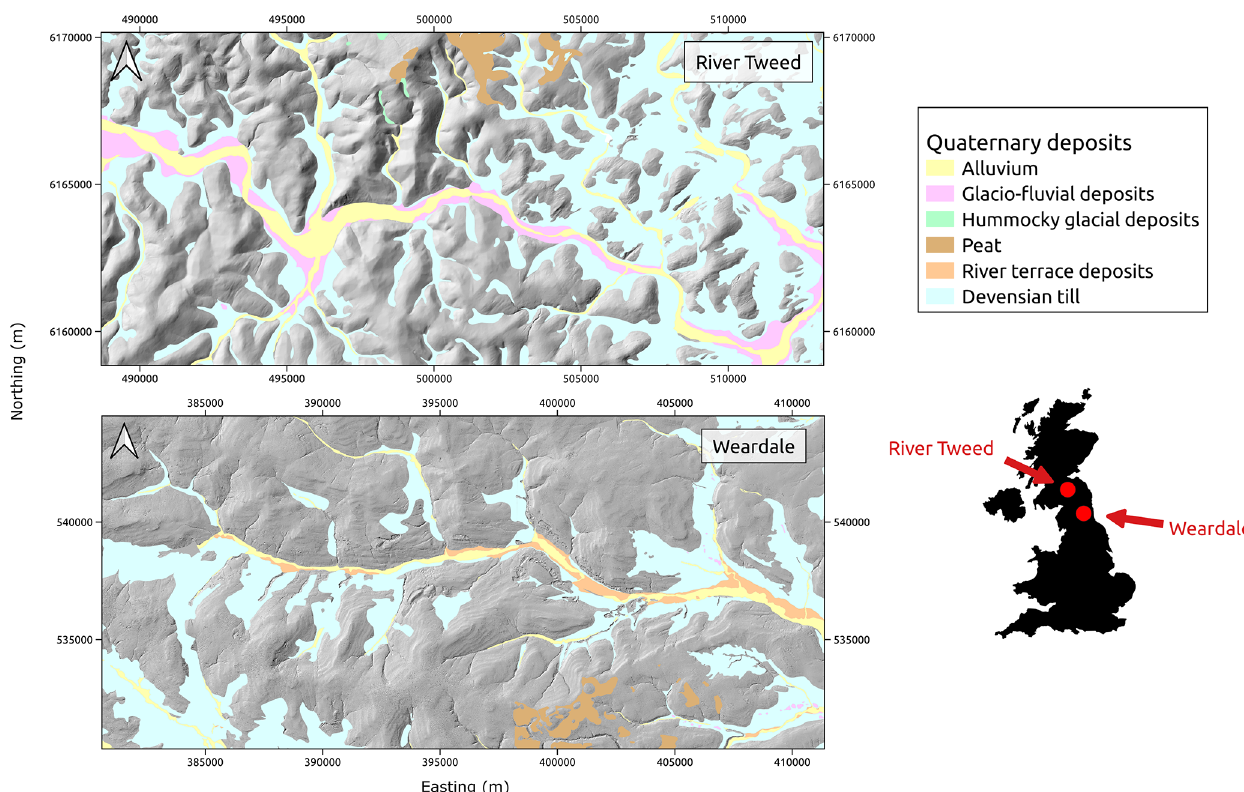
Figure 4. Hillshade of the River Tweed and Weardale showing the extent of superficial Quaternary deposits mapped by the BGS. We define the valley as the extent of the alluvium and river terrace deposits combined. The red stars show the approximate location of the sites in the UK. The coordinate system is WGS84, UTM zone